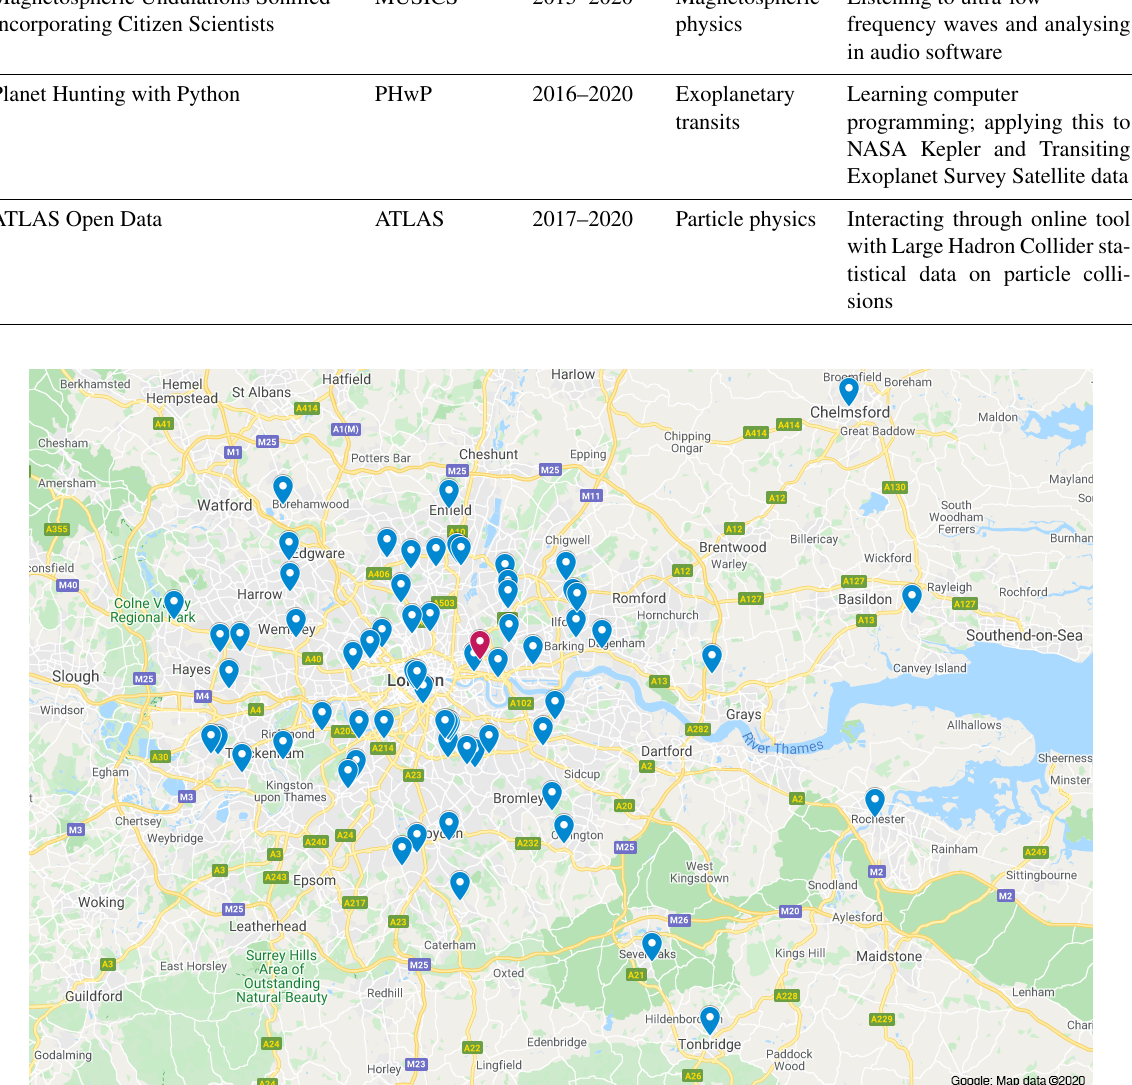
Figure 1. Map of all schools involved with PRiSE (blue), with the Queen Mary University of London location shown in red. Source: ©Google Maps,